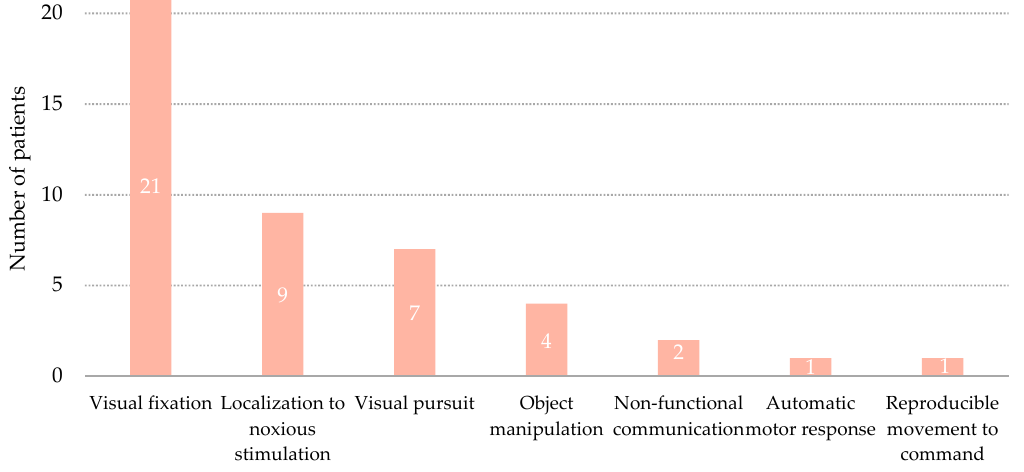
Figure 3. Distribution of patients per items of the Coma Recovery Scale that denoted Minimally Conscious State. The univariate logistic regressions of the cross-validation featured age as a potential predictor in two iterations, and etiology, time since injury and total score on the CRS-R in all five iterations. All these variables were consequently included in the multivariable lo- gistic regression of the final model but only etiology, time since injury and total score on the CRS-R proved to be significant predictors. The p -value of the likelihood-ratio test of all the regression models was <0.001. Etiology was the most important variable contrib- uting to predict the transition to MCS, followed by the score on the CRS-R (Table 2). Spe- cifically, patients with traumatic injuries were almost five times more likely to transition to MCS than patients with non-traumatic injuries, and one-point increase in the CRS-S at admission doubled the likelihood of transition to MCS. Although the influence of time since injury on the final model was significant, the odds ratio of this factor showed that either it was not actually associated with transition to MCS or the association was weak. As hypothesized, the performance of the model in the training subsets was better than in validation subsets, while differences were not significant (Table 2). The AUC val- ues, greater than 0.8 in both the training and validation subsets supported the good per- formance of the final model. Regarding performance on new data, the model showed an accuracy to identify patients who did and did not transitioned to MCS of 75%. Transition to MCS occurred in 67% of the patients who were predicted to transition. From all the patients who actually transitioned to MCS, the model only predicted 56% of them cor- rectly. In contrast, the model properly detected 85% of the patients who remained in UWS. Table 2. Parameters and validation metrics of the predictive model of transition to Minimally Conscious State. Multivariable Logistic Regression Model